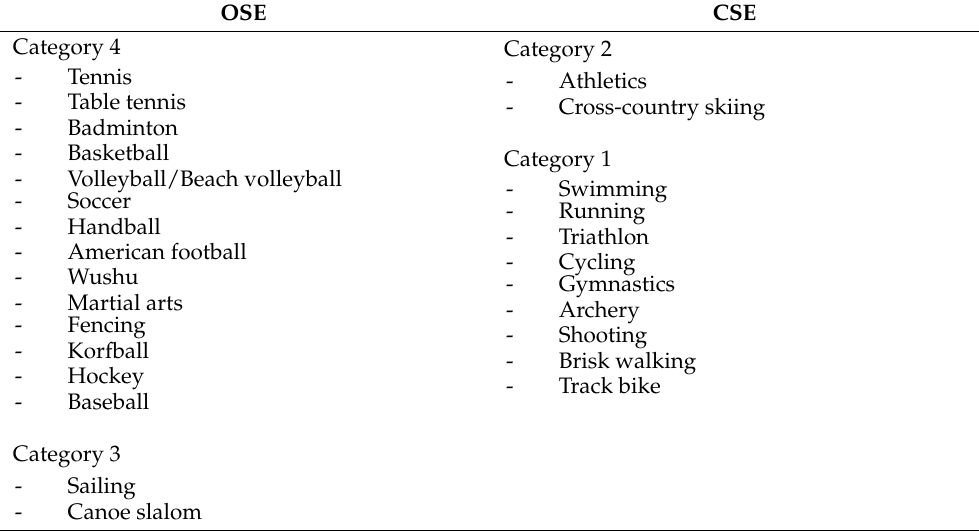
Abbreviations: CSE, closed-skill exercise; OSE, open-skill